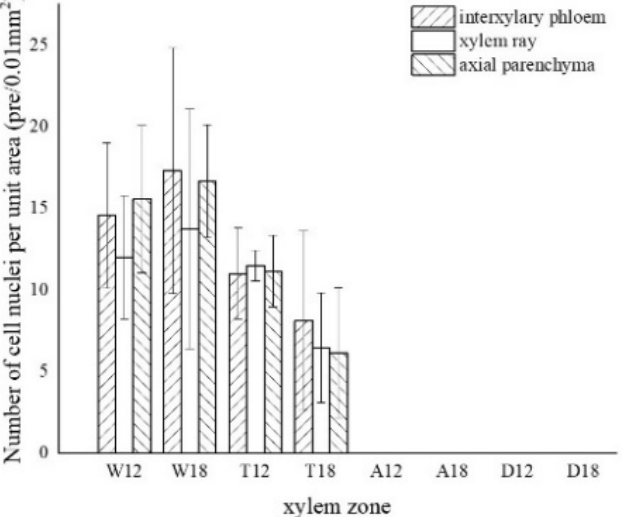
Figure 5. Variation in the number of nuclei in a different zone of cells. W—white zone; T—transition zone; A—agarwood zone; D—decay zone; 12—inoculated for 12 months; 18—inoculated for 18 months.